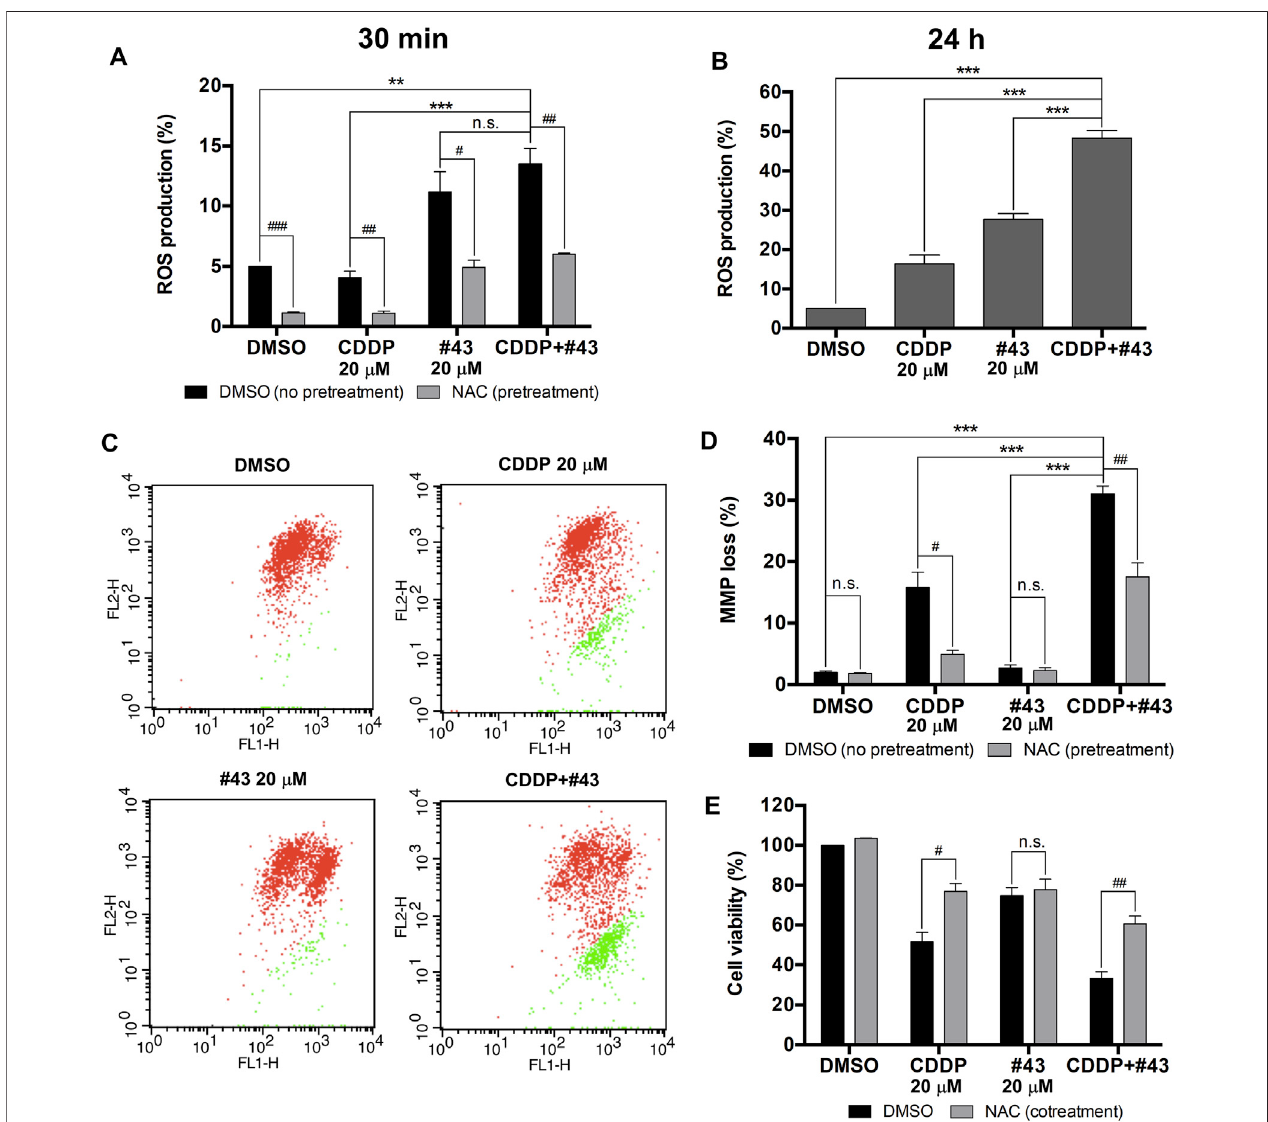
FIGURE 4 | Induction of ROS and mitochondrial membrane potential loss by the combination of cisplatin and #43 in MCF-7 cells. (A) ROS production of cells treated with 20 μ M cisplatin and/or 20 μ M #43 for 30 min with or without 2 mM NAC pretreatment by the DCFH-DA assay. (B) ROS production of cells treated with 20 μ M cisplatin and/or 20 μ M #43 for 24 h. (C) Dot plots of JC-1 assay after 48 h of drug treatment to measure the mitochondrial membrane potential. Cells with intact MMP are labeled in red and cells with MMP loss are labeled in green. (D) Quantitative results of JC-1 fl ow cytometric analysis. NAC (2 mM) was added as an antioxidant which reversed MMP loss. (E) NAC rescued cells from growth inhibition by cisplatin and the combination of cisplatin and #43. Cells were treated with 20 μ M cisplatin and/or 20 μ M #43 for 72 h with or without 2 mM NAC, followed by the MTT assay. Data are presented as mean ± SEM of at least three independent experiments. *, p < 0.05; **, p < 0.01; ***, p < 0.001; n. s., not signi fi cant ( p > 0.05) by one-way ANOVA followed by Bonferroni t -test. # , p < 0.05; ## , p < 0.01; ### , p < 0.001; n. s., not signi fi cant ( p > 0.05) by the two-tailed Student ’ s t